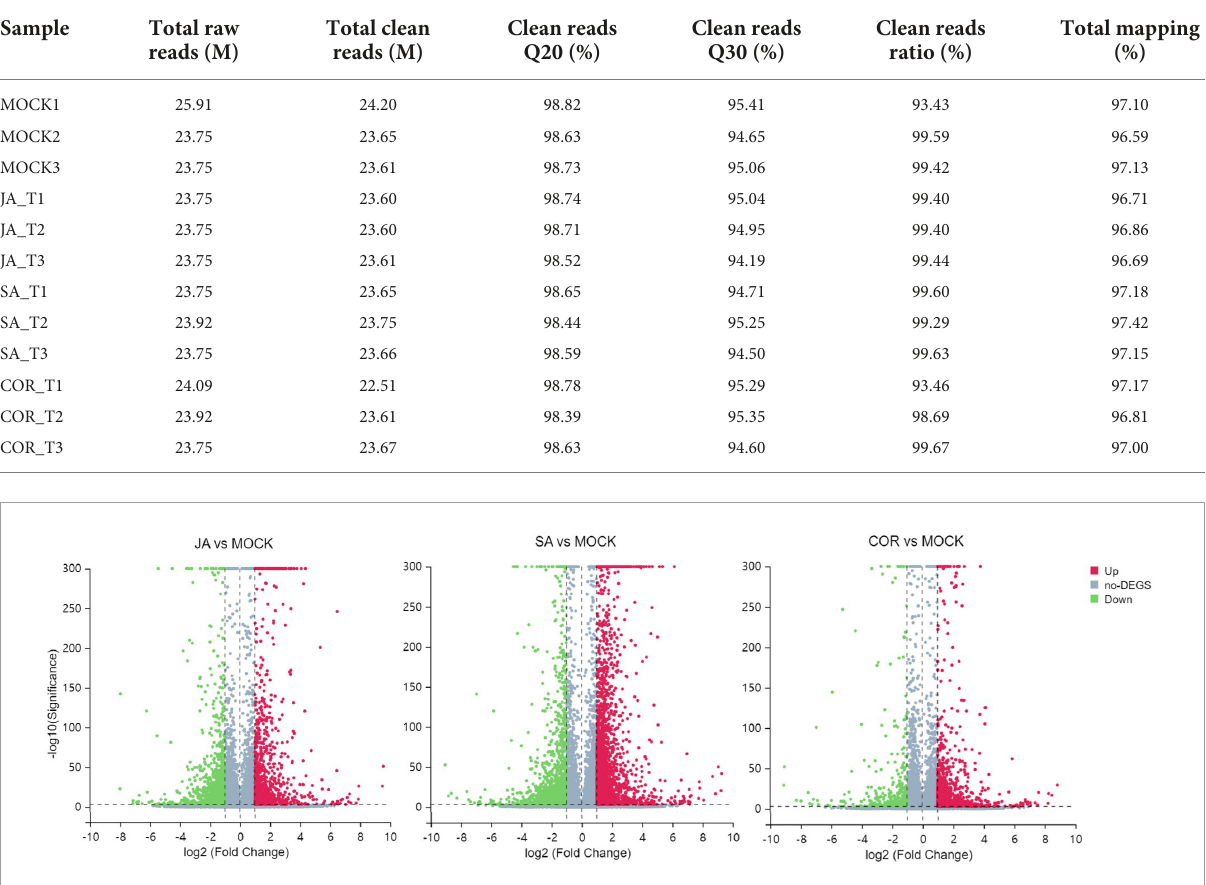
accumulation. COR treatment resulted in a 10-fold